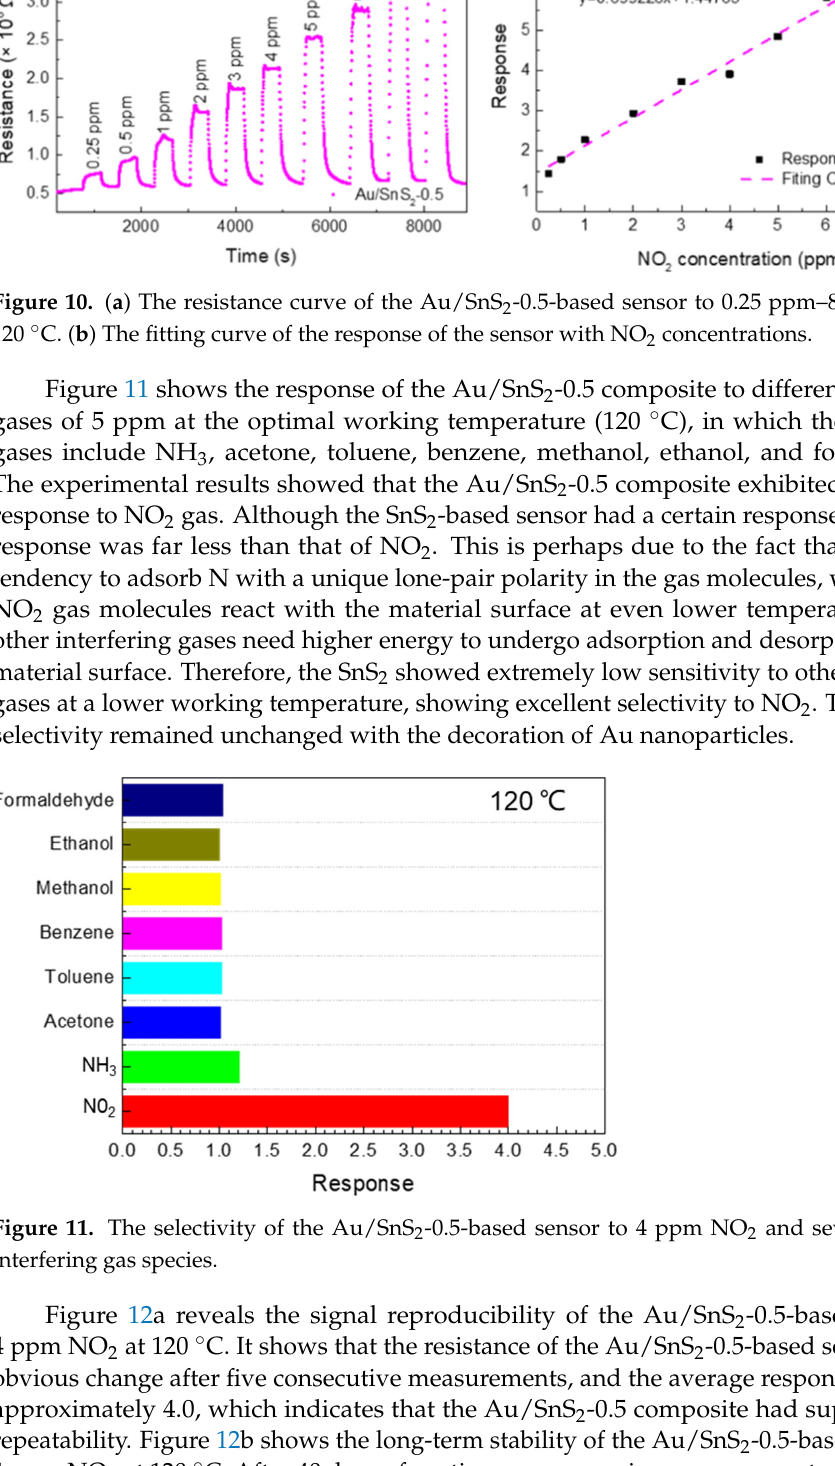
Figure 10. ( a ) The resistance curve of the Au/SnS 2 -0.5-based sensor to 0.25 ppm–8 ppm NO 2 at 120 °C. ( b ) The fitting curve of the response of the sensor with NO 2 concentrations.